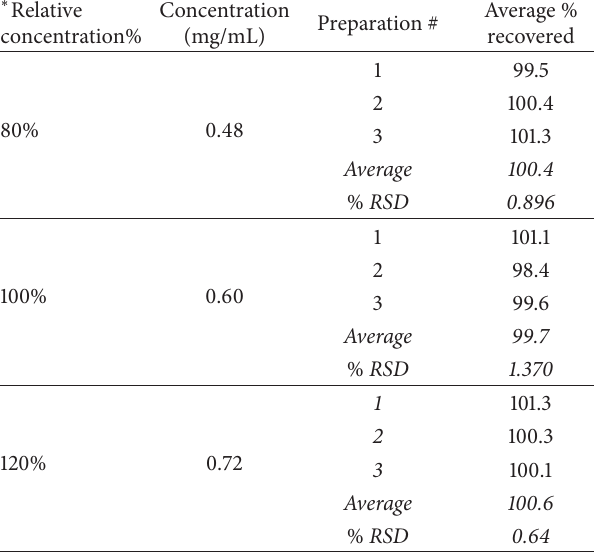
Table 4: Accuracy results for menthol.